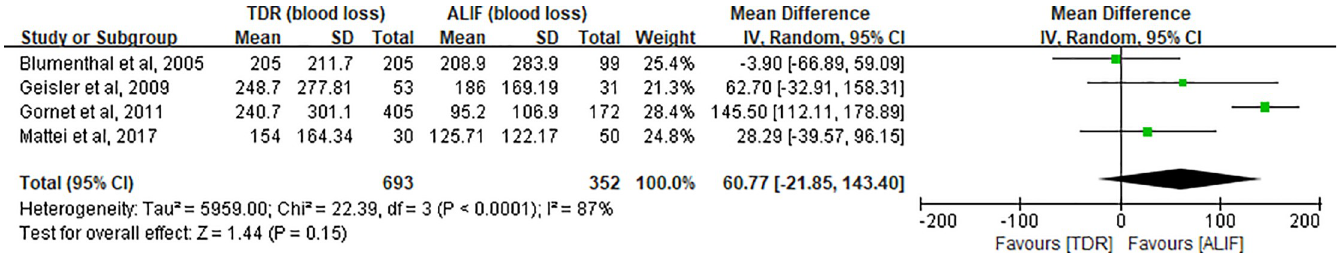
PLOS ONE | https://doi.org/10.1371/journal.pone.0209660 December28,